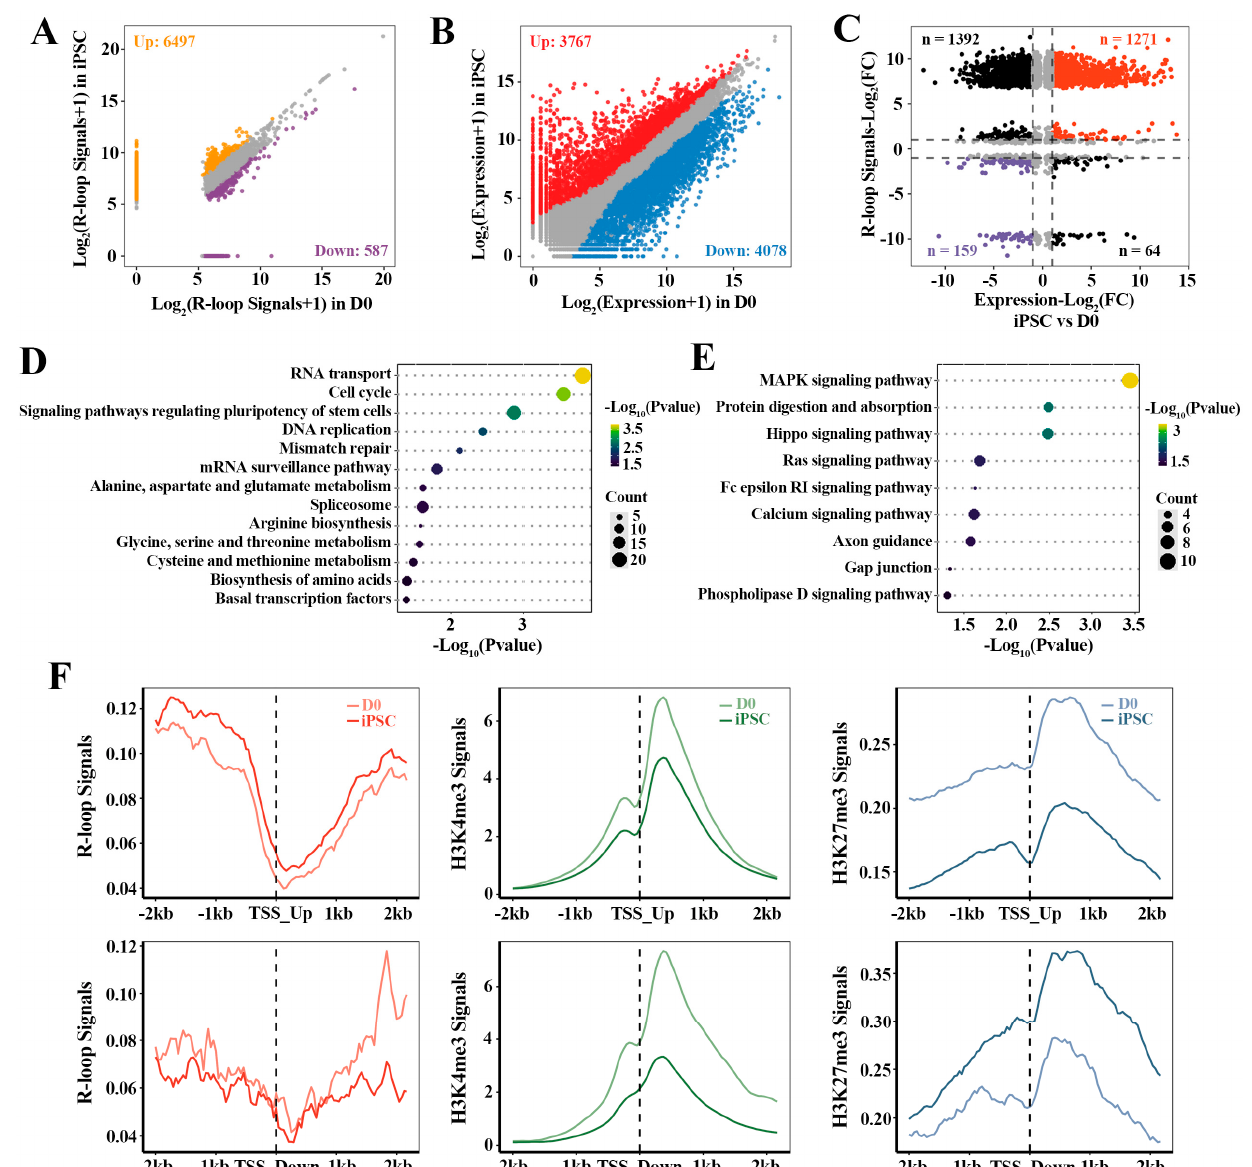
Figure 3. The dynamic effect of R-loops on gene expression in reprogramming: ( A ) analysis of differential R-loop signals in iPSC vs. D0; ( B ) analysis of differential gene expression in iPSC vs. D0; ( C ) scatterplots showing the relationship between R-loops and gene expression during reprogramming process. Red dots are the genes whose expression levels and R-loop signals are up-regulated in iPSC compared to D0. Purple dots are the genes whose expression levels and R-loop signals are down-regulated in iPSC; ( D , E ) KEGG pathway analysis of up-regulated genes with higher R-loop signals ( n = 1271) and down-regulated genes with lower R-loop signals ( n = 159); ( F ) the read density profiles of R-loops, H3K4me3 and H3K27me3 at the 2 kb flanking TSSs of the up-regulated genes ( n = 1271, upper three panels) and down-regulated genes ( n = 159, lower three panels). Fibroblast reprogramming to the pluripotent state is governed by multiple epigenetic marks, whereby active epigenetic modifications direct cell identity away from the fibro- blast, and repressive epigenetic marks are inherited from the fibroblasts [31]. In order to by R-loops, we also calculated the signal intensities (Figure 3F) of active histone marker (H3K4me3) and inhibitory histone marker (H3K27me3) around the TSSs (TSS ± 2 kb) of